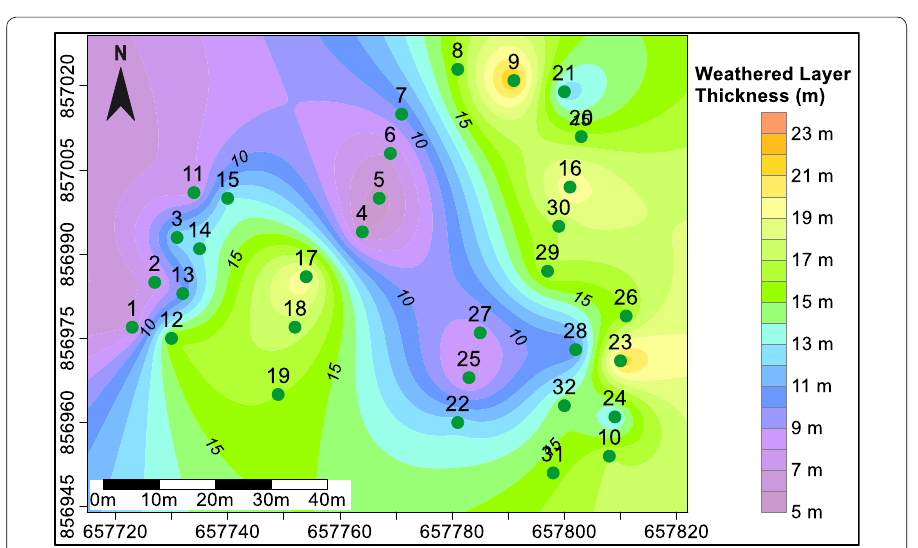
Fig. 11 Isopach map showing the weathered layer thickness